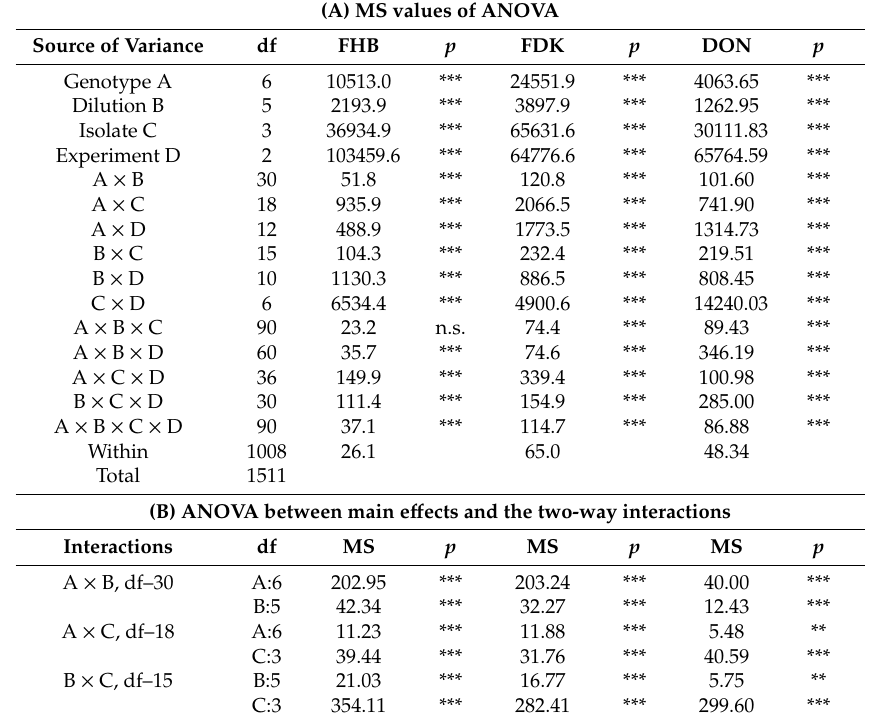
Table 10. ANOVA of the DI, FDK, and DON data in the inoculum dilution tests, MS values, 2013 and 2014. ( A ) MS values of ANOVA. ( B ) ANOVA between main e ff ects and the two-way